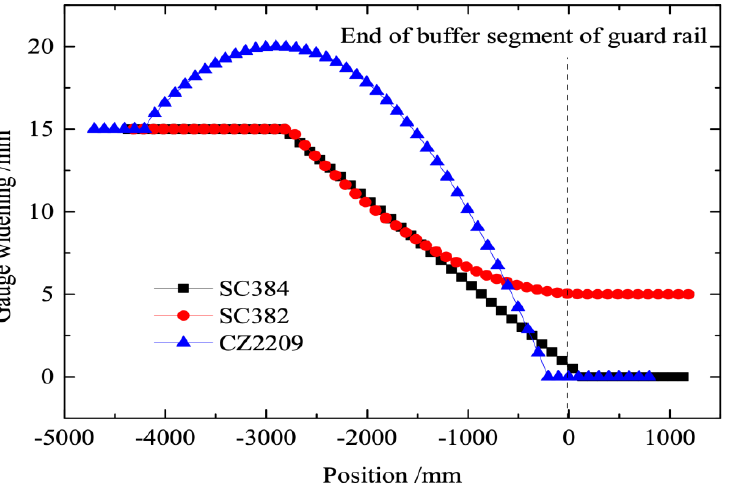
Figure 14. Comparison of variation laws of SC384, SC382, and CZ2209 turnout gage widening.